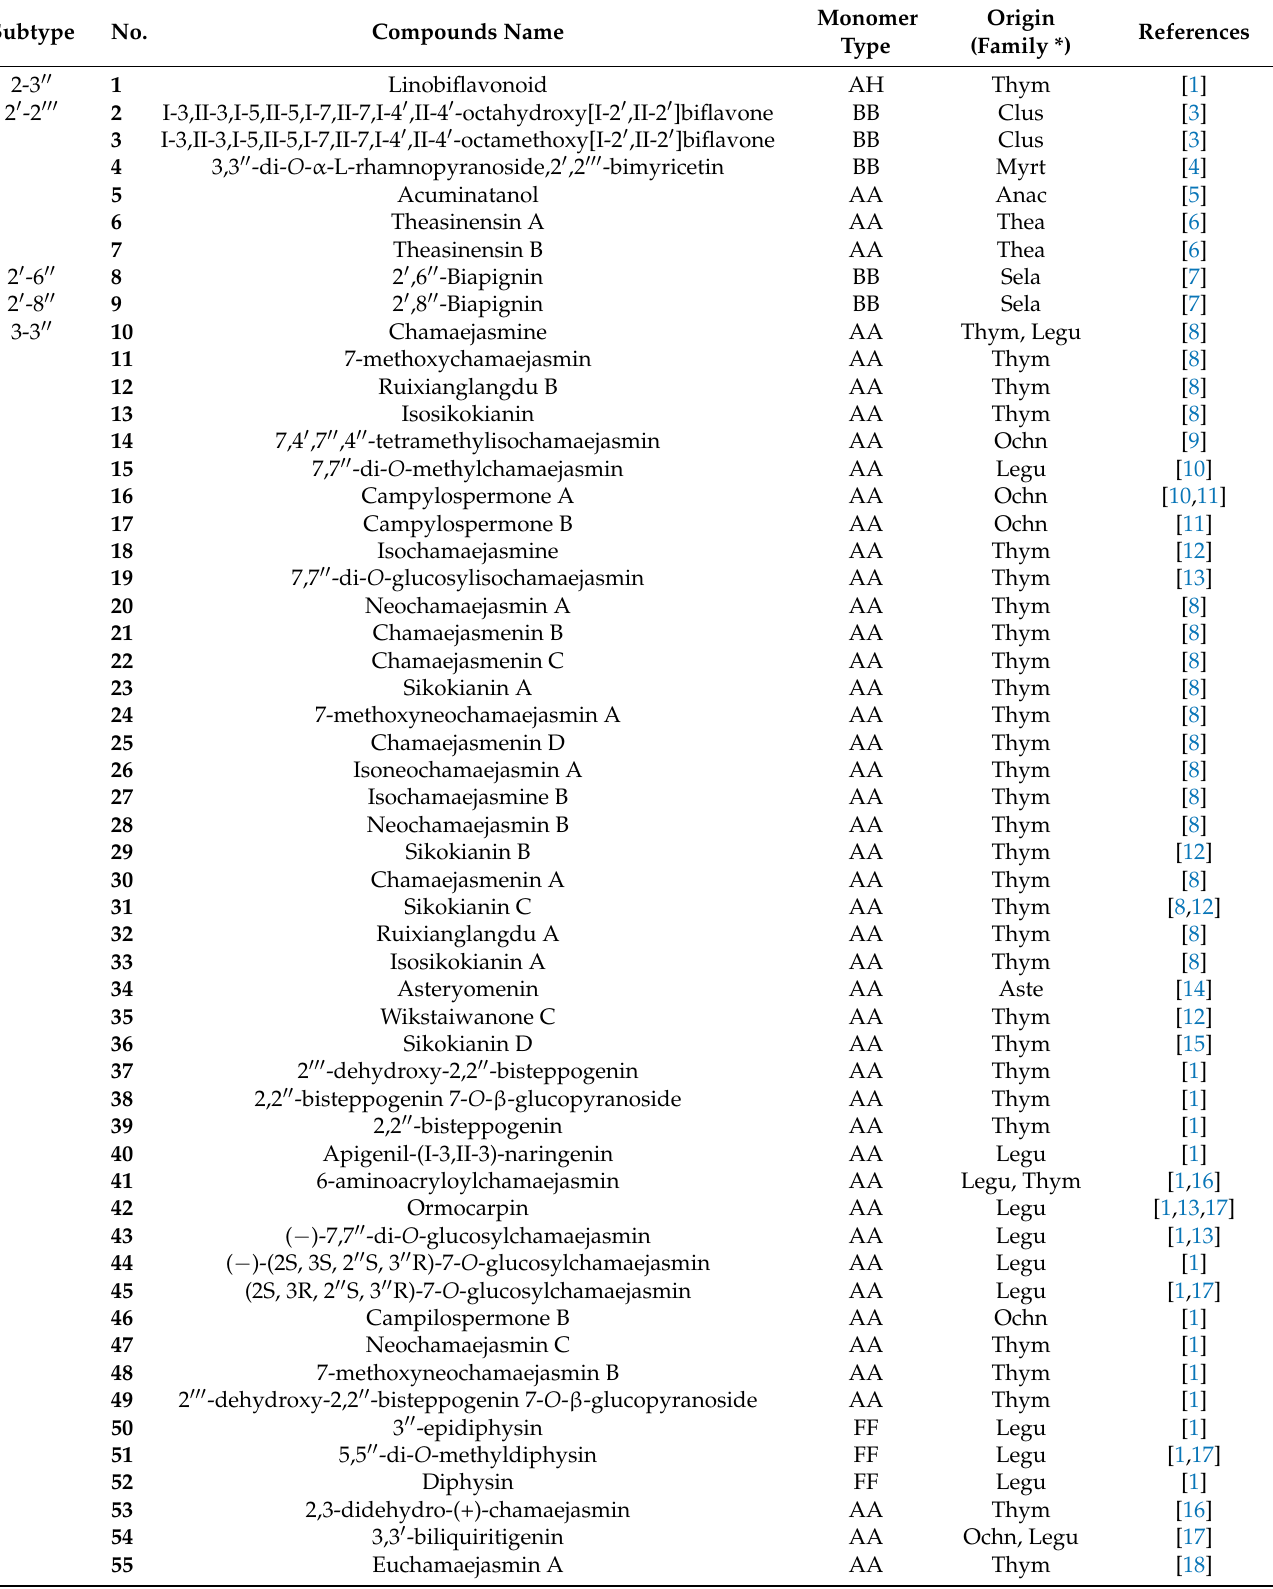
Table 1. The 2-3 (cid:48)(cid:48) , 2 (cid:48) -2 (cid:48)(cid:48)(cid:48) , 2 (cid:48) -6 (cid:48)(cid:48) , 2 (cid:48) -8 (cid:48)(cid:48) , and 3-3 (cid:48)(cid:48) subtypes of